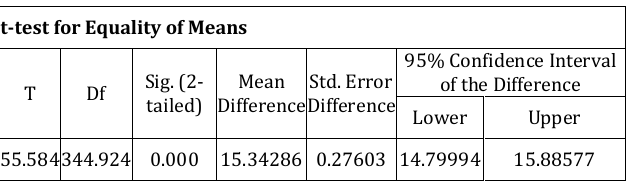
Table 7: T-test for comparison of means between both sites (Site-1 Canal Park and Site-2 Gat Wala Park)